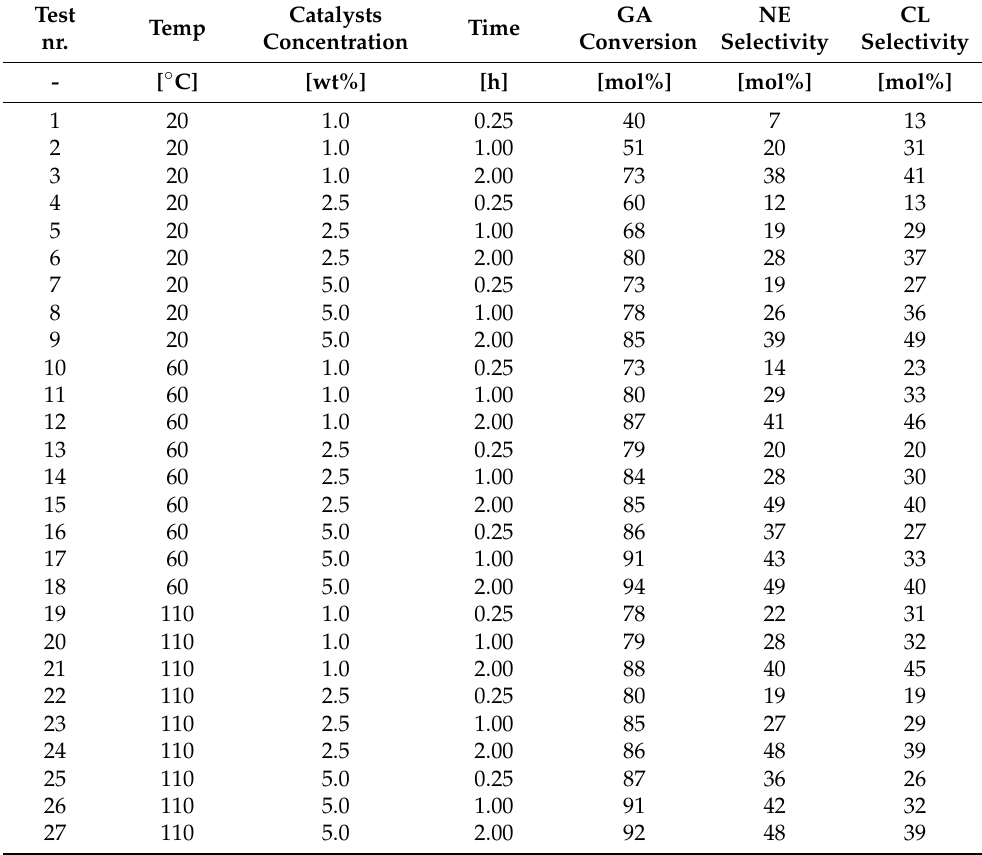
Table 7. Details of the conducted